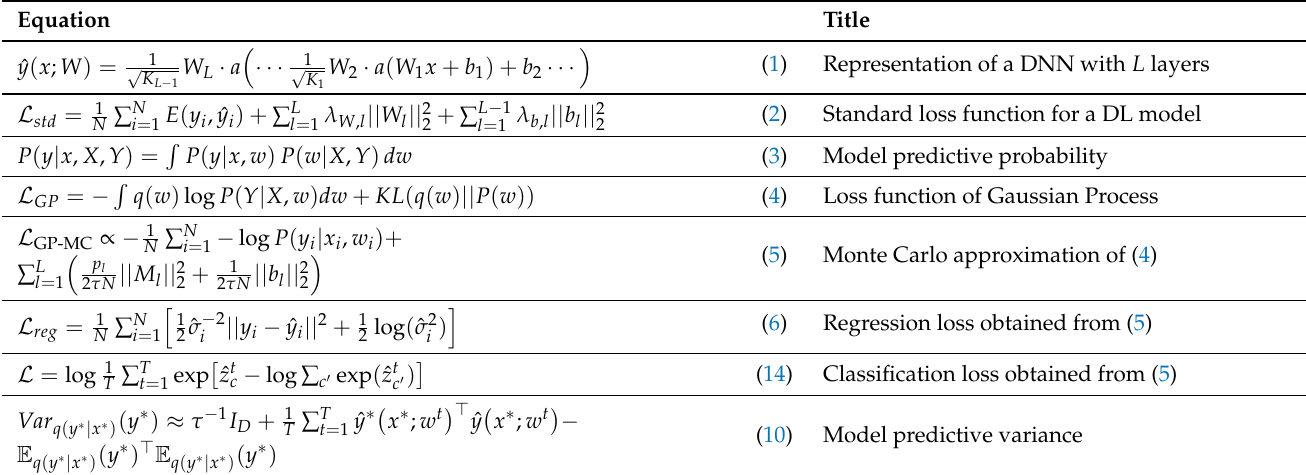
Table 2. BNN equation